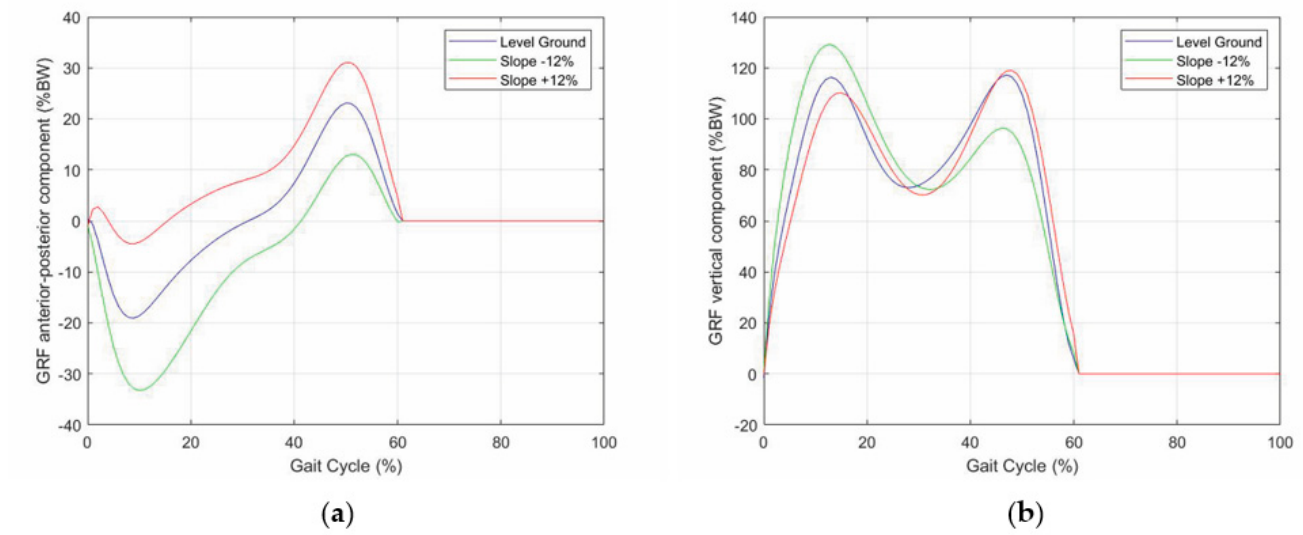
Figure 10. GRF components as a function of the gait-cycle percentage for three different longitudinal slopes: ( a ) anterior- posterior component, and ( b ) vertical component.